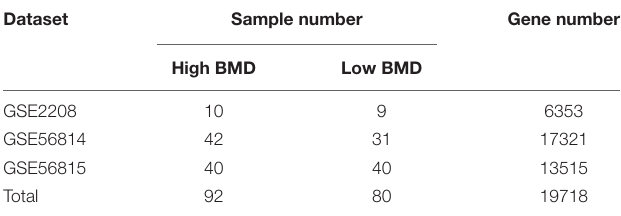
TABLE 1 | The overview of three GEO datasets.